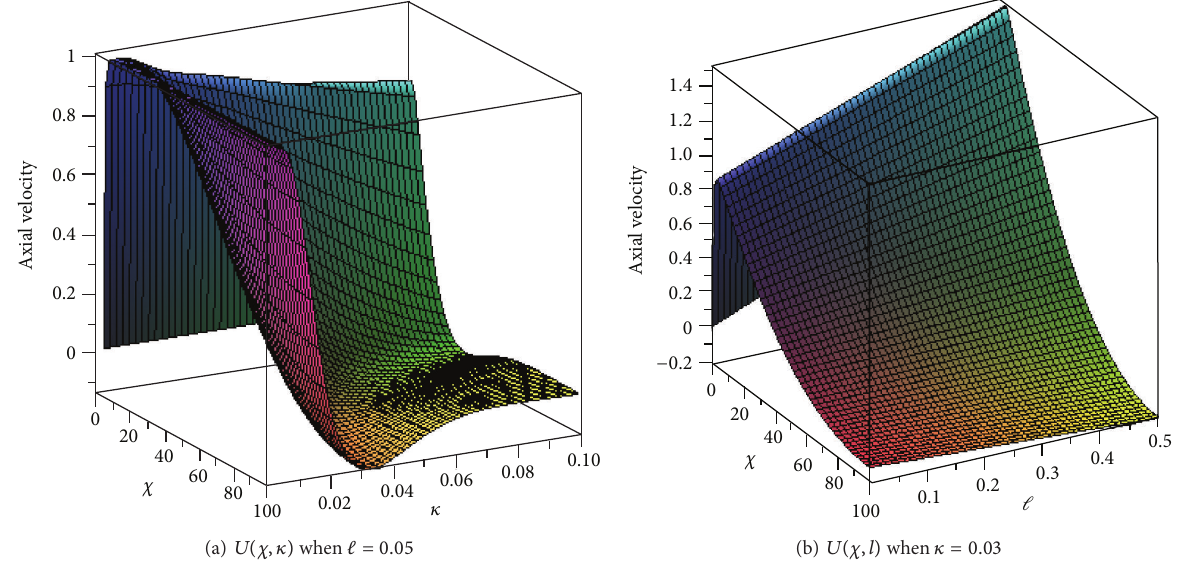
Figure 4: 3D plot of 𝑈(𝜒,𝜅) and 𝑈(𝜒,𝑙) obtained from the model with 𝜃 = 𝜋/2 , 𝛼 = 1 , and ℎ = 100 𝜆